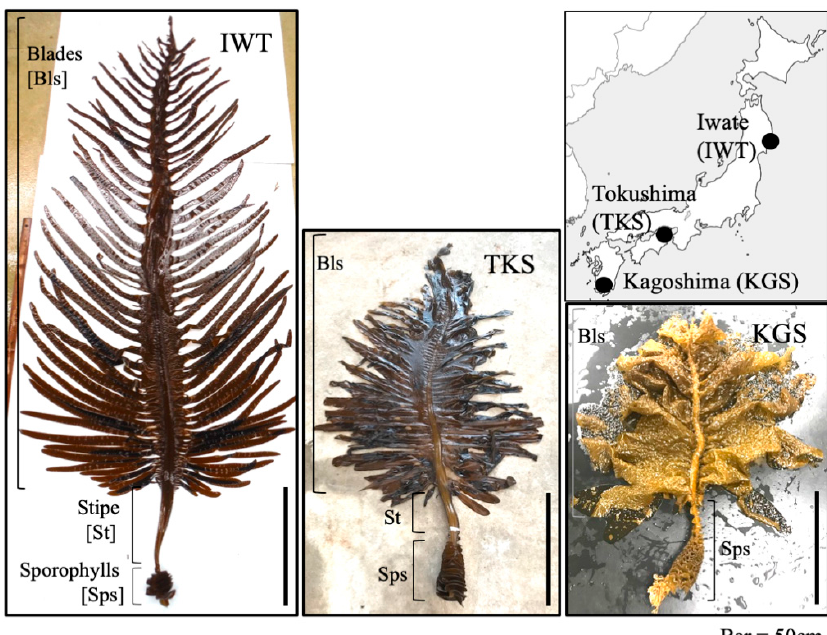
Figure 1. The three localities where Undaria pinnatifida thalli were collected and the corresponding sporophytes. Scale bar 50 cm. IWT—Iwate, TKS—Tokushima,